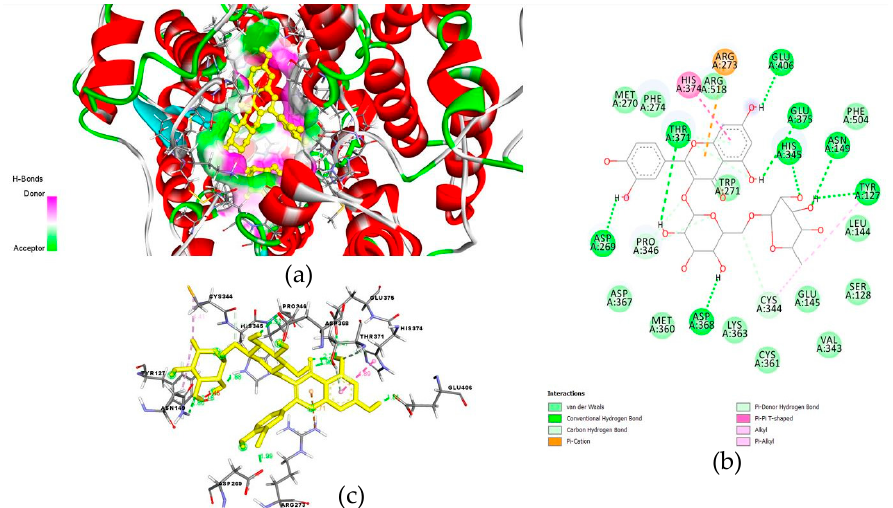
Figure 4. Binding pose ( a ) along with 2D ( b ) and 3D ( c ) analysis of molecular interaction of rutin within the active site of ACE-II. Reproduced with permission from Güler et al. [48], ScienceOpen Preprints, 2020, http://creativecommons.org/licenses/by/4.0/.